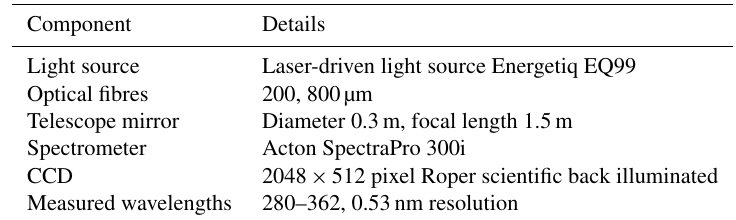
Table 1. Characteristics of the LP-DOAS system.